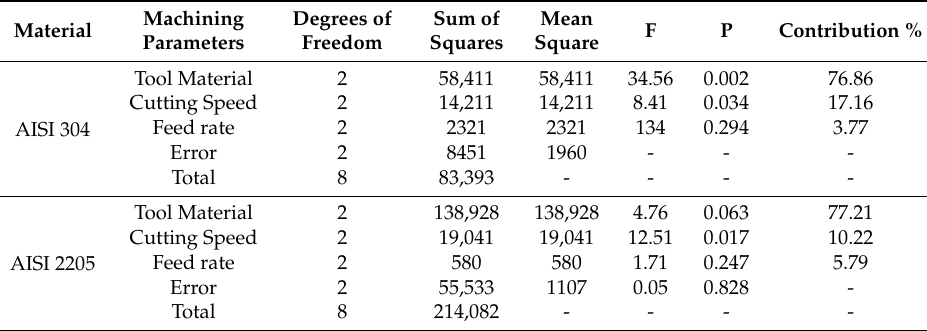
Table 7. Results of analysis of variance (ANOVA) for tool